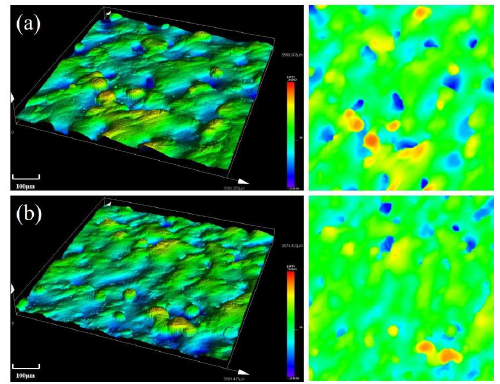
Figure 14. Surface topography of the SLM alloy formed at different laser powers: ( a ) 380 W and ( b ) 460 W.